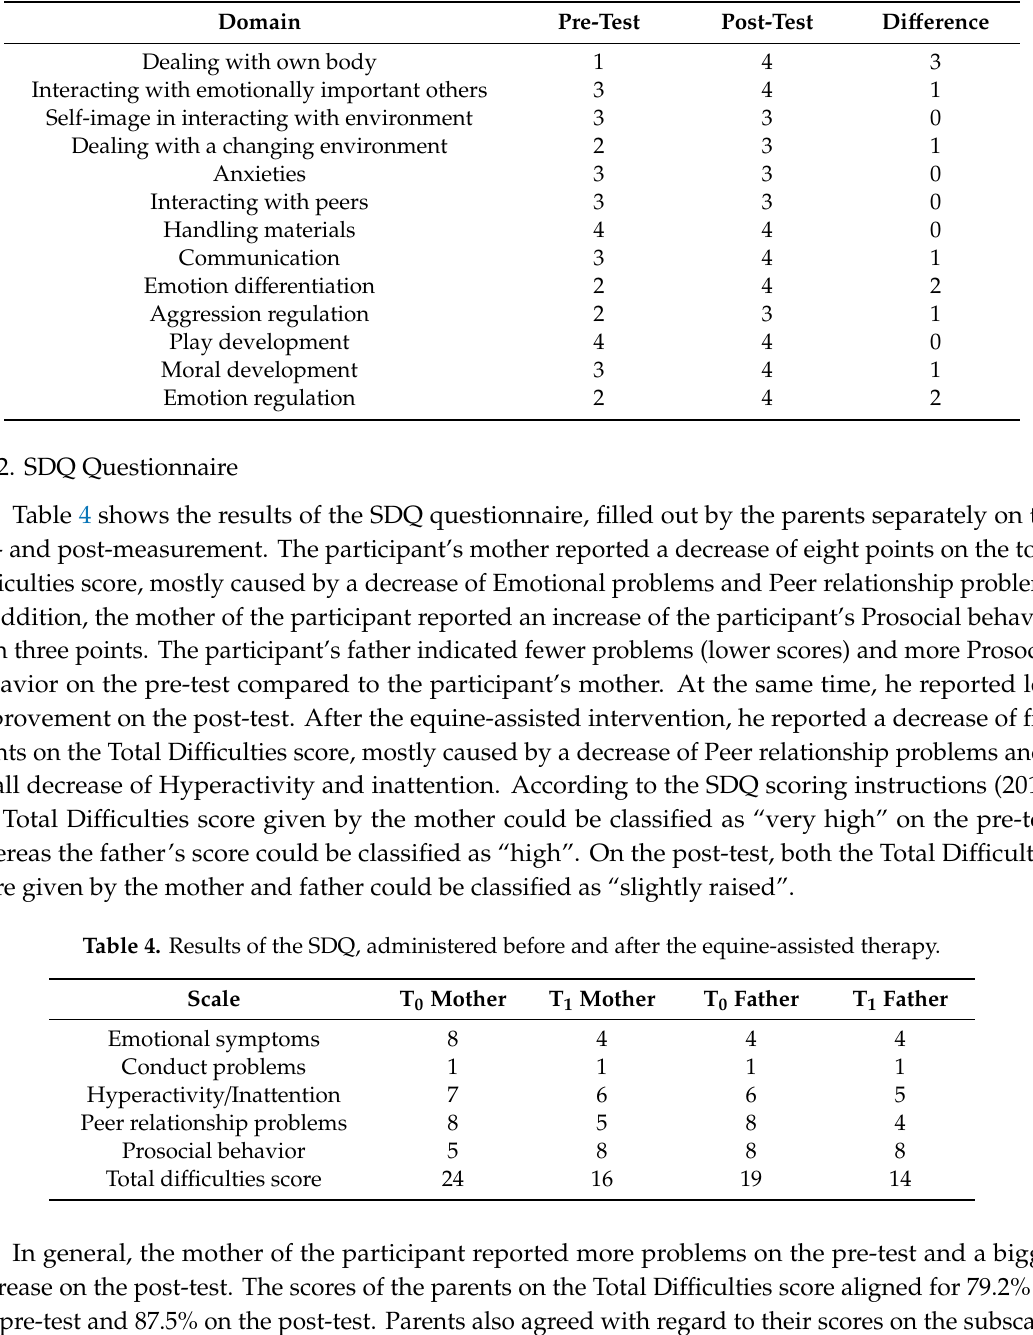
Table 3. Results of the Scale for Emotional Development-Revised (SED-R), administered before and after the intervention.